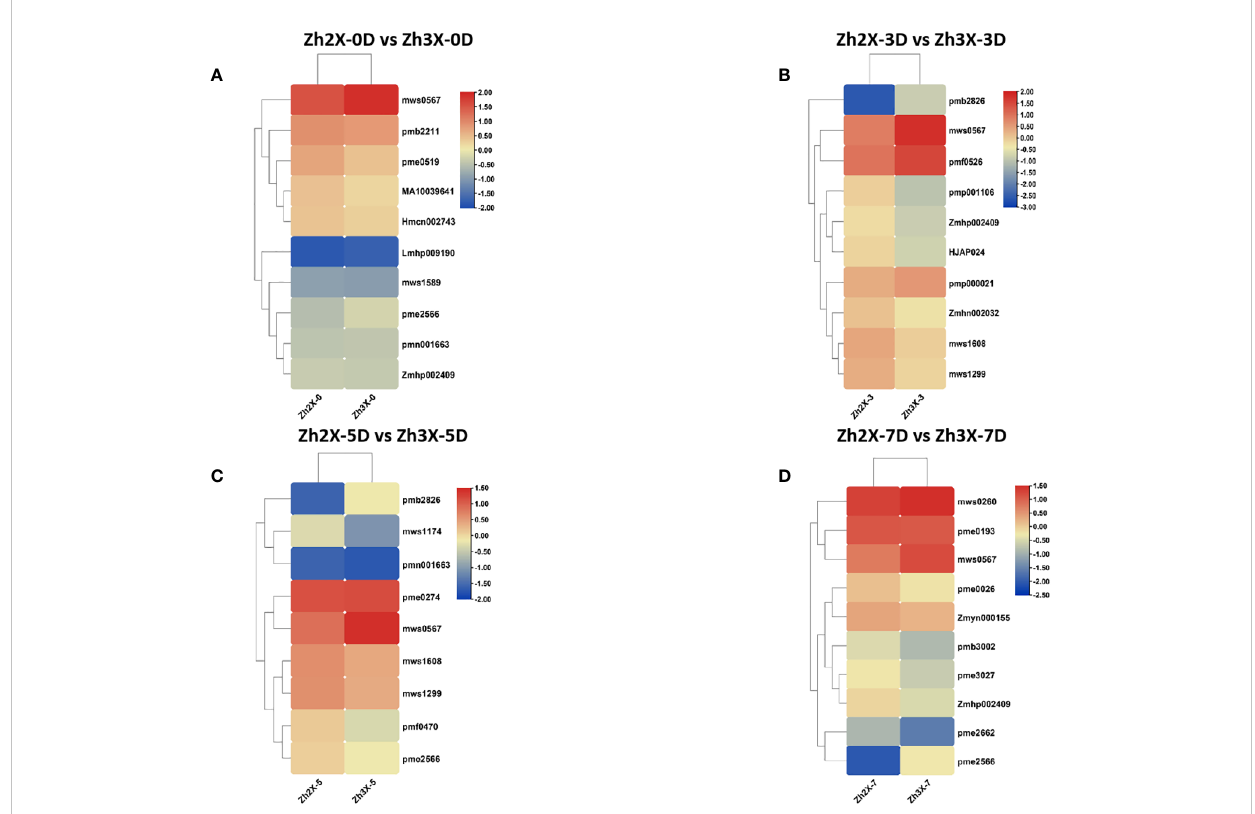
FIGURE 10 Variations in Top Foldchange metabolites among 2X and 3X watermelon. (A) Expression of metabolites in Zh2X-0D vs Zh3X-0D comparison group (B) Expression of metabolites in Zh2X-3D vs Zh3X-3D comparison group (C) Expression of metabolites in Zh2X-5D vs Zh3X-5D comparison group, and (D) Expression of metabolites in Zh2X-7D vs Zh3X-7D comparison group.